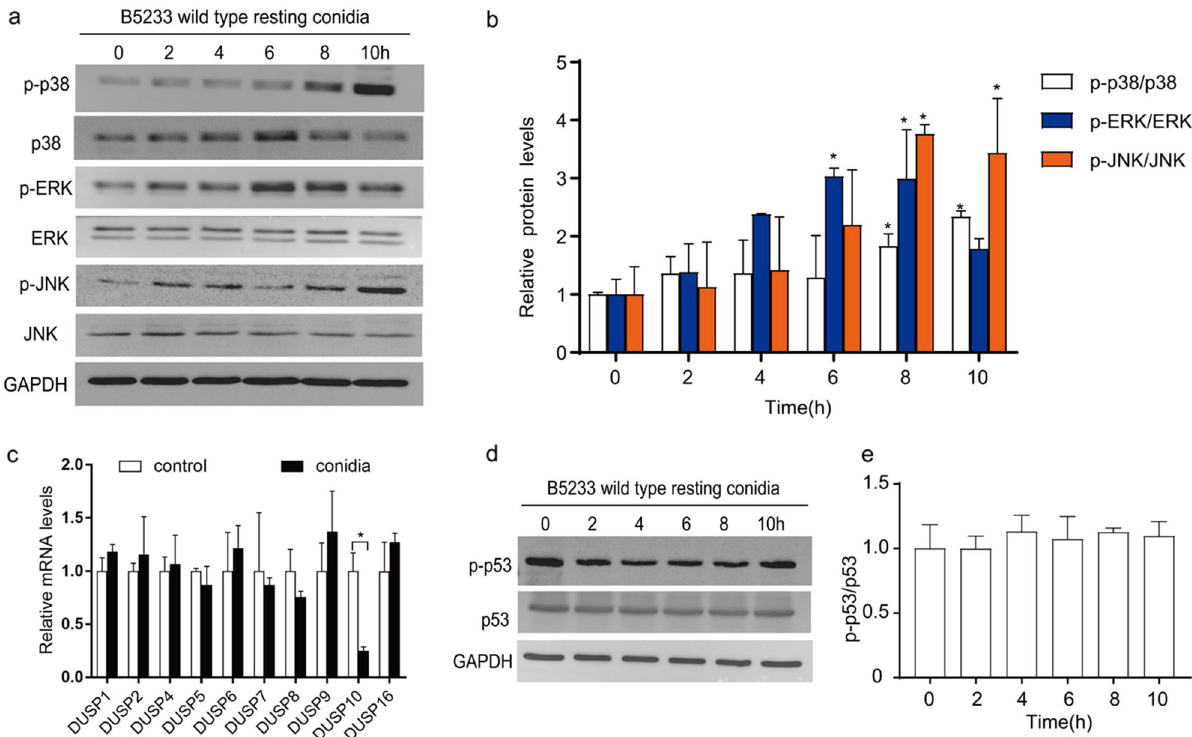
Figure 2. Activation of MAPK signaling pathways by A. fumigatus conidia in bronchial epithelial cells. BEAS-2B cells were stimulated with resting conidia of A. fumigatus at an MOI of 10 for the indicated times. ( a , b ) Phosphorylation of p38 MAPK, ERK and JNK were measured and analyzed. The blots were cut prior to hybridisation with antibodies during blotting. ( c ) The mRNA level of DUSPs was measured by RT-qPCR after stimulated for 8 h. ( d , e ) Phosphorylation of p53 were measured and analyzed. The blots were cut prior to hybridisation with antibodies during blotting. The data shown as mean ± SD and represented 3 independent experiments. * P < 0.05 versus the control